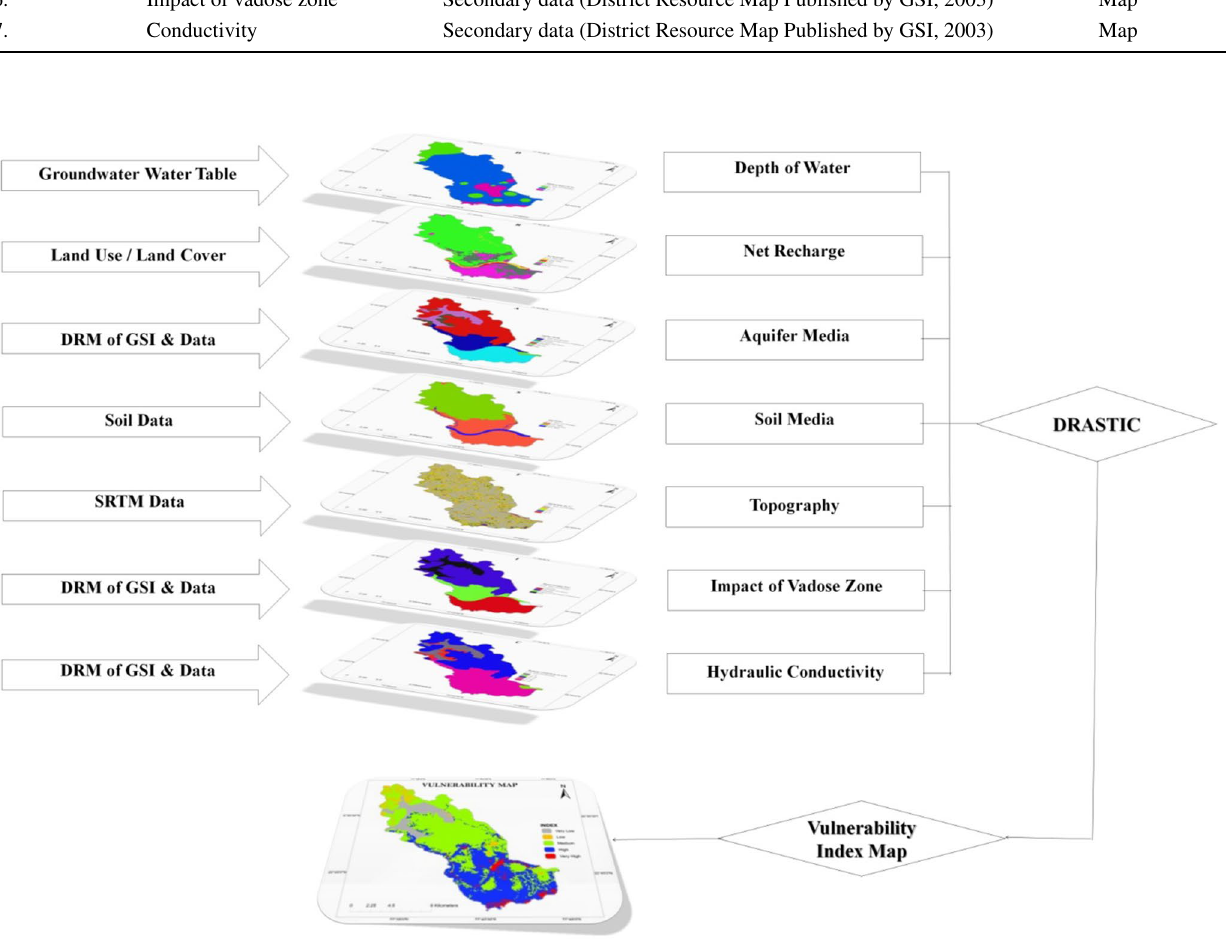
Fig. 2 Methodology flow